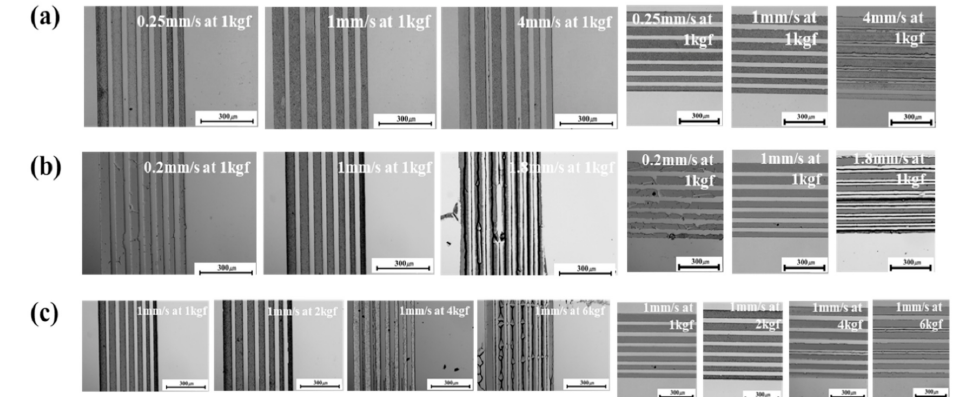
Figure 3. ( a ) Horizontal and vertical printing patterns according to the DLB offset roll speed change in the transfer step. ( b , c ) Horizontal and vertical printing pattern according to the DLB offset roll speed change and pressure change in the off step.